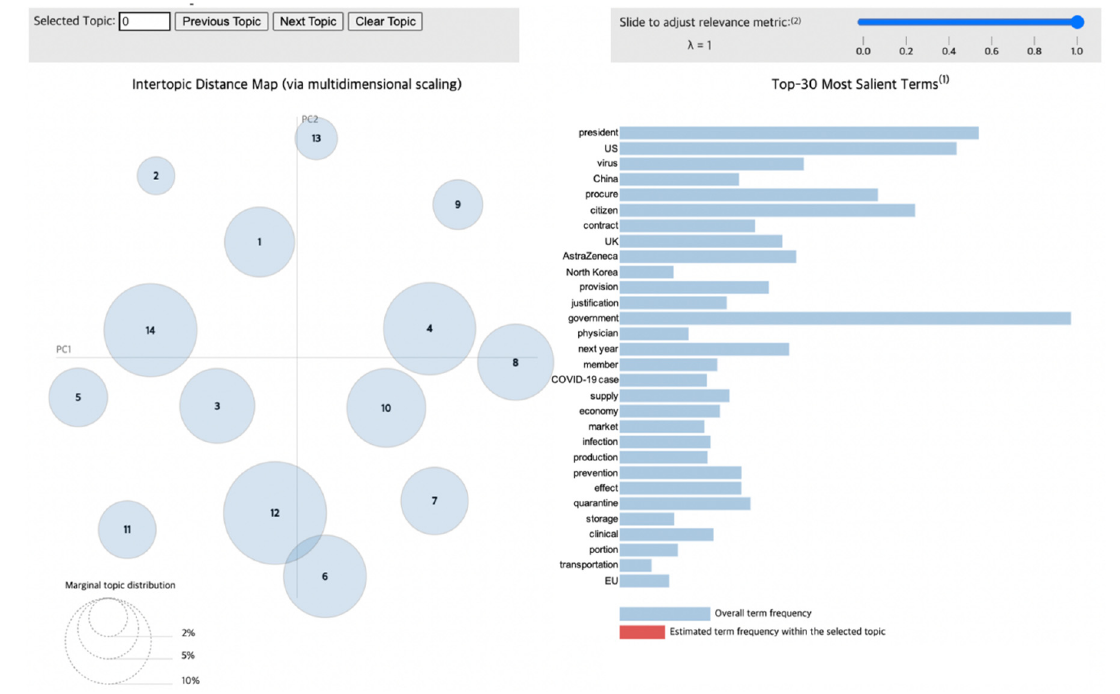
Figure 6. Topic visualization of Phase 2.